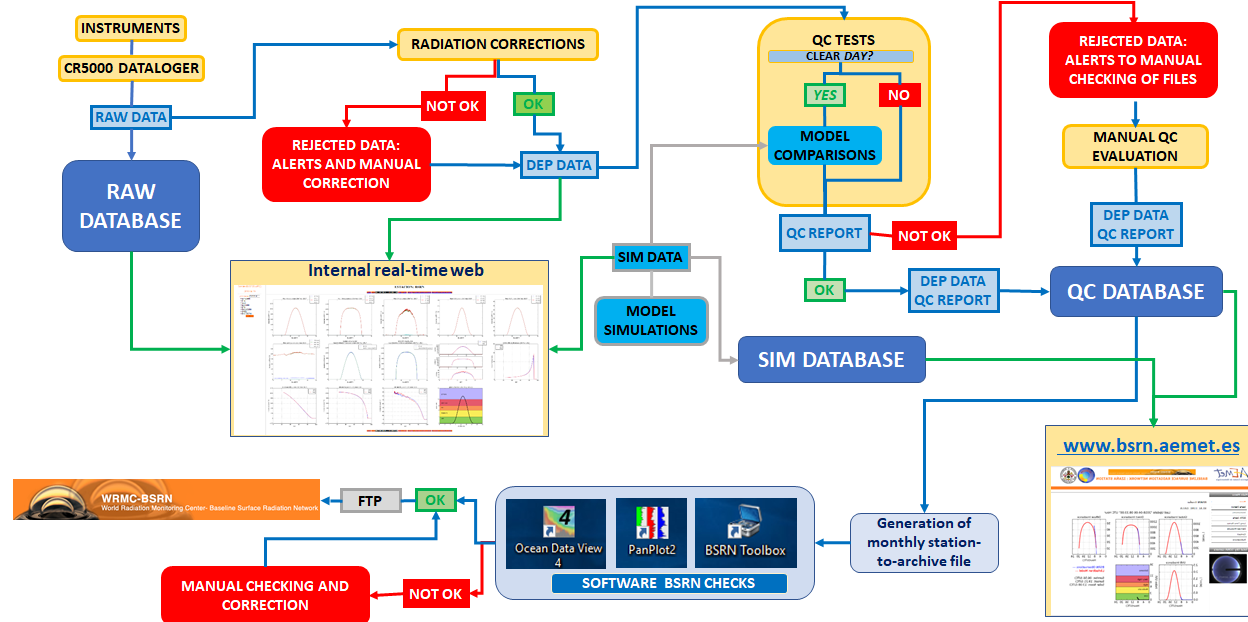
Figure 7. Flowchart of data from measurements to the BSRN database. Table 4. The lower and upper limits for the physically possible limits (PPLs) and extremely rare limits (ERLs) used in flagging the radiation measurements. µ o is the cosine of the solar zenith angle and S a is the solar constant adjusted for the Earth–Sun distance. Lower bound (Wm − 2 ) Upper bound (Wm − 2